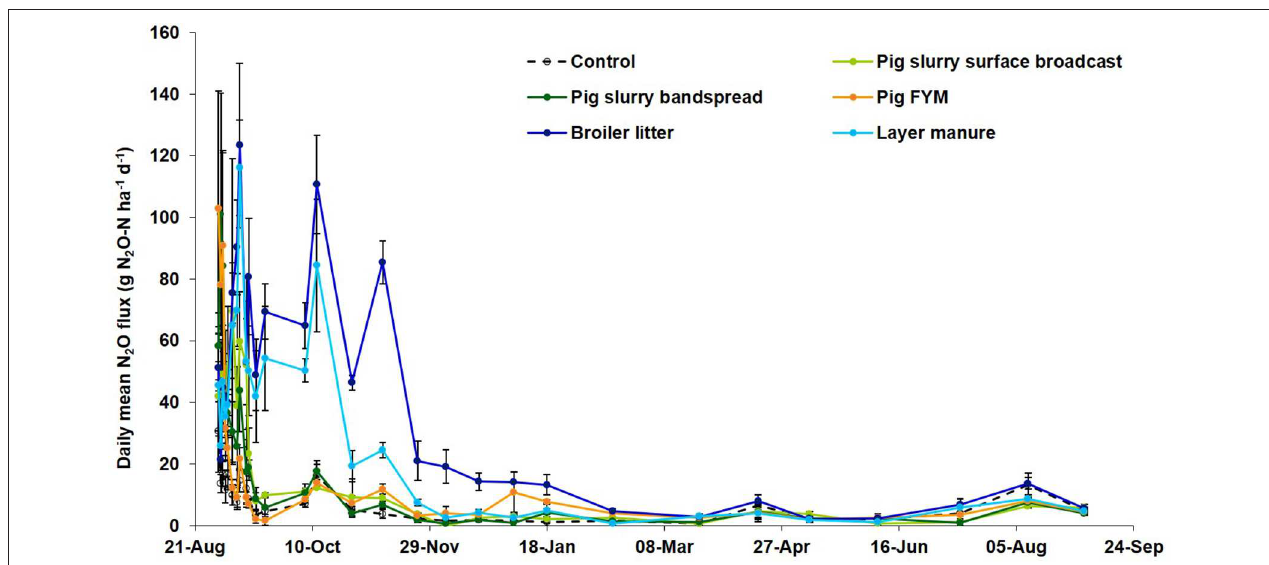
FIGURE 3 | Daily mean N 2 O flux at Wensum following manure applications in autumn 2011 (vertical lines ± 1 standard error, N = 3